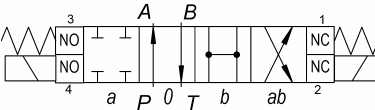
Figure 3. Connection diagram of a configuration with two NO and two NC seat valves.